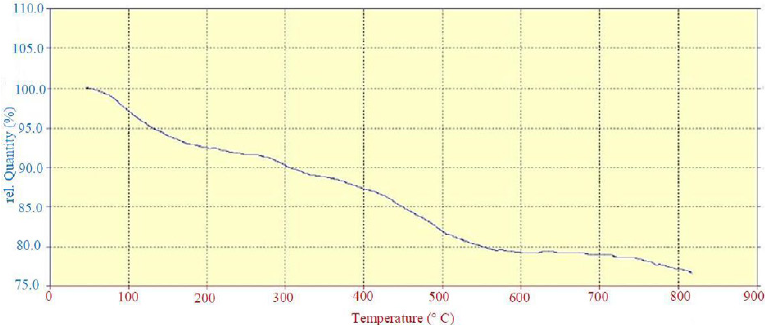
Fig. 5. TGA curve of H 3 PW 12 O 40 -amino-functionalized CdFe 12 O 19 @SiO 2